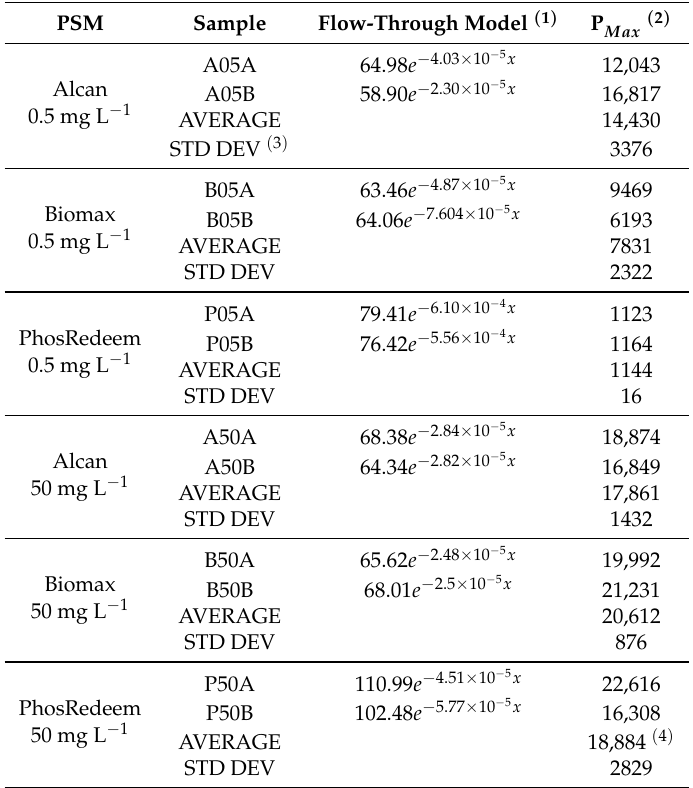
Table 2. Preliminary performance and subsequent maximum phosphorus (P) removed (P Max ) by three P sorption materials (PSMs) under flow-through conditions of 0.5 and 50 mg P L − 1 inflow and 0.284 min residence time. The P Max values were used as the target for initial P saturation in regeneration